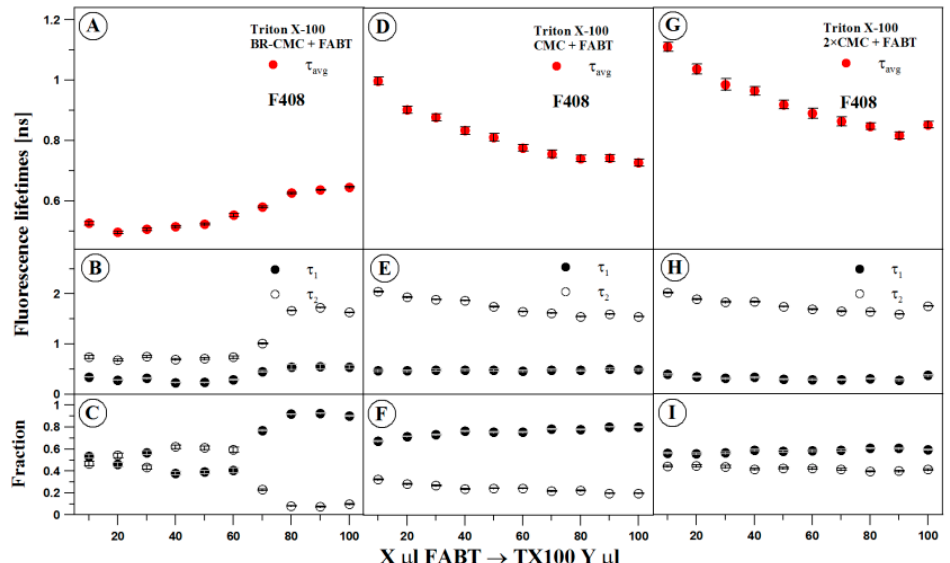
Figure 10. Correlation between fluorescence lifetimes and the amount of FABT added to the aforementioned amounts of detergent. Panels ( A , D , G ) present average fluorescence lifetimes observed for various amounts of Triton X-100. Panels ( B , E , H ) show fluorescence lifetimes of the first ( τ 1 ) and the second ( τ 2 ) component of FABT, observed for various concentrations of FABT in Triton X-100. The dependences of the fraction of both components on FABT in Triton X-100 values are presented in Panels ( C , F . I ). Panel ( C ) presents the results of the experiment conducted for the Triton X-100 in the amount of 10 µ L per 3 mL of the buffer (BR-CMC), Panel ( F ) for 50 µ L (CMC) of and Panel I for 100 µ L (2 × CMC) of the detergent. The data analysis was carried out for the two components model (Equation (1) for i = 2) for data presented in Figure 9. The spectra were recorded at the temperature of 22 °C.